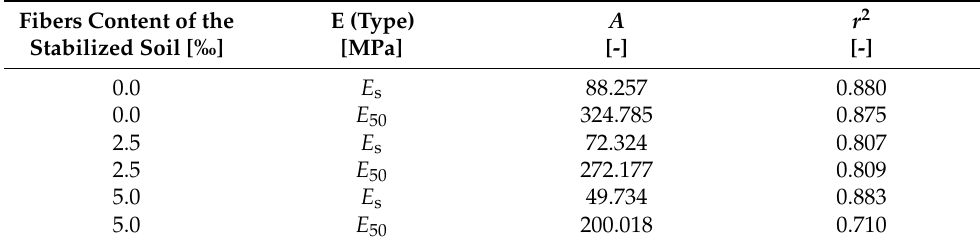
Table 9. Parameter A for determining the prediction of modulus values for stabilized soils. Fibers Content of the Stabilized